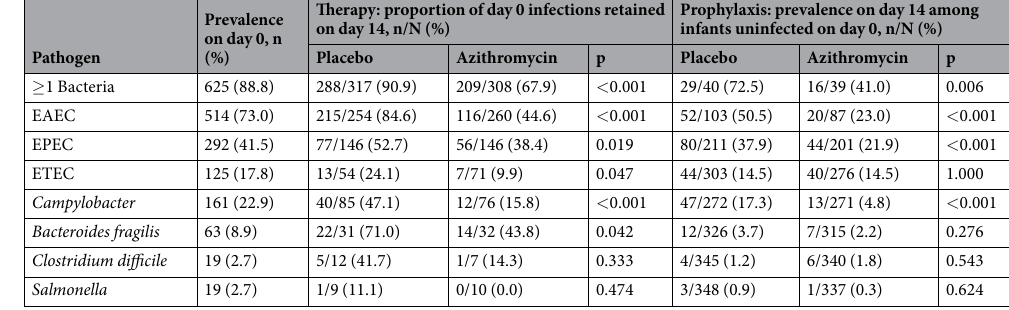
Table 2. Therapeutic versus prophylactic effects of azithromycin. Prevalence was compared according to study arm using Fisher’s exact test. Bacterial enteropathogens present in at least 2% of infants on day 0 are included. Abbreviations: EAEC, enteroaggregative Escherichia coli ; EPEC, enteropathogenic E. coli ; ETEC, enterotoxigenic E. coli